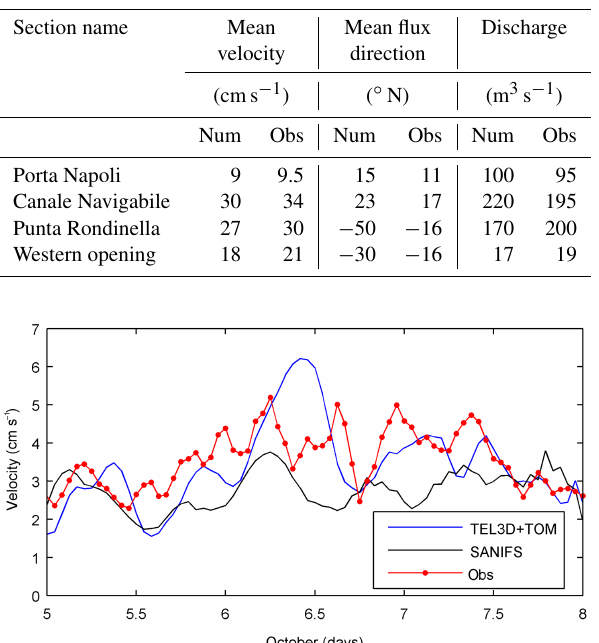
Table 3. Water mass exiting Mar Grande on 5 October 2014: com- parison between numerical results (Num) from TEL3D + TOM and observations (Obs) from the four ADCP transects as reported in Fig. 3.